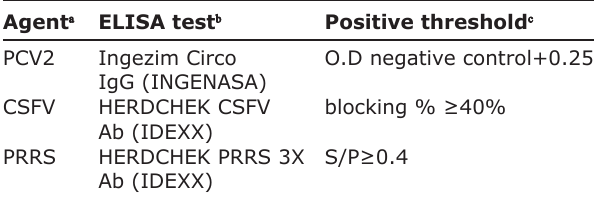
Table-1: ELISA kit used for the detection of specific antibody with cutoff